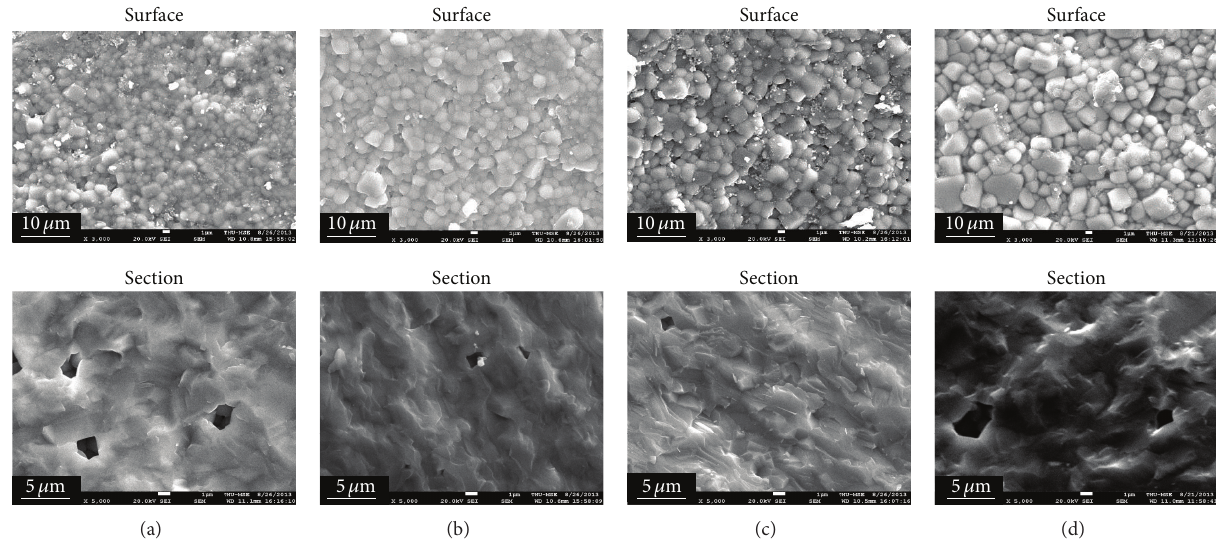
Figure 4: Images of Scanning Electron Microscope at different sintering temperatures for CaTiO 3 at (a) 1250 ∘ C, (b) 1300 ∘ C, (c) 1350 ∘ C, and (d) 1400 ∘ C by surface and section.